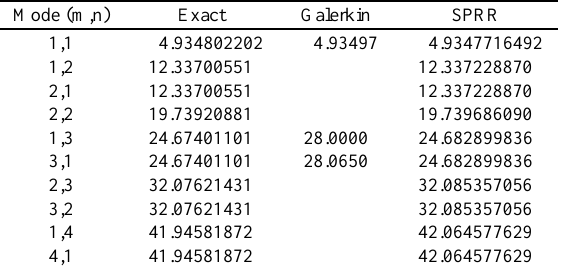
Table 2 Natural frequencies of a square membrane. SPRR, Rayleigh Ritz method with spline